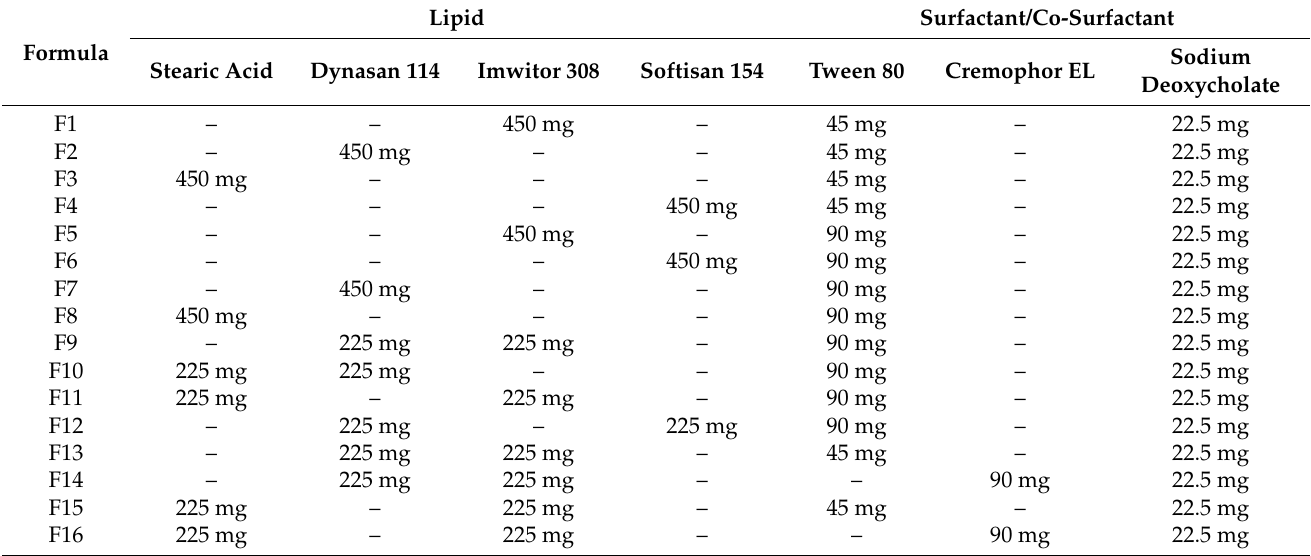
Table 1. Compositions of the prepared CXB-Loaded